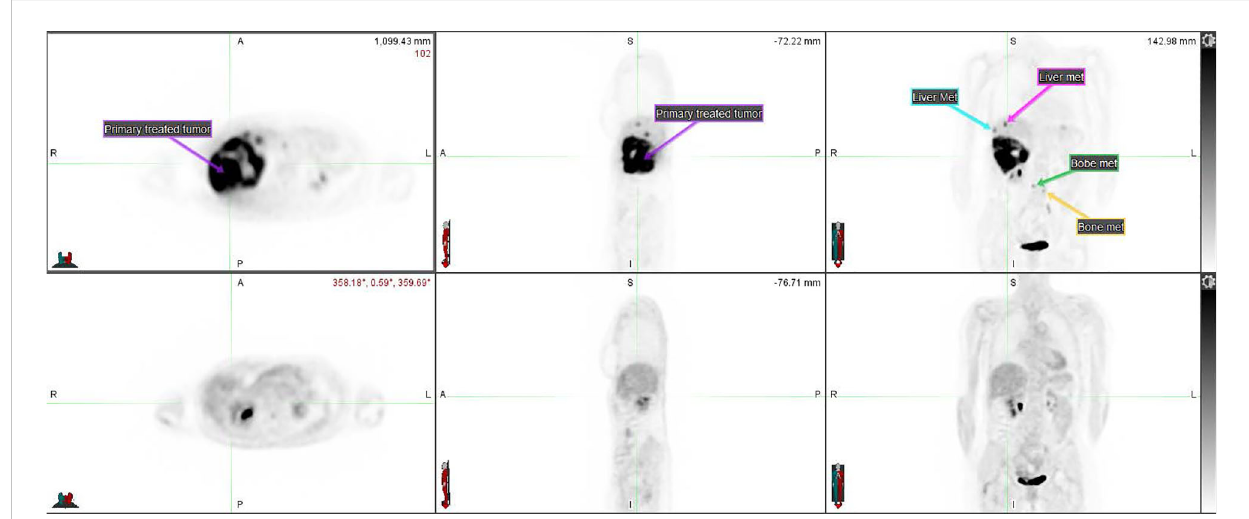
FIGURE 3 PET CT comparison of the disseminated disease before (top row) and after (bottom row) the SBRT course combined with ImT (nivolumab/relatlimab). The primary tumor treated with SBRT (compare to Figure 2) as well as some of the metastases are annotated on the pre-treatment imaging.